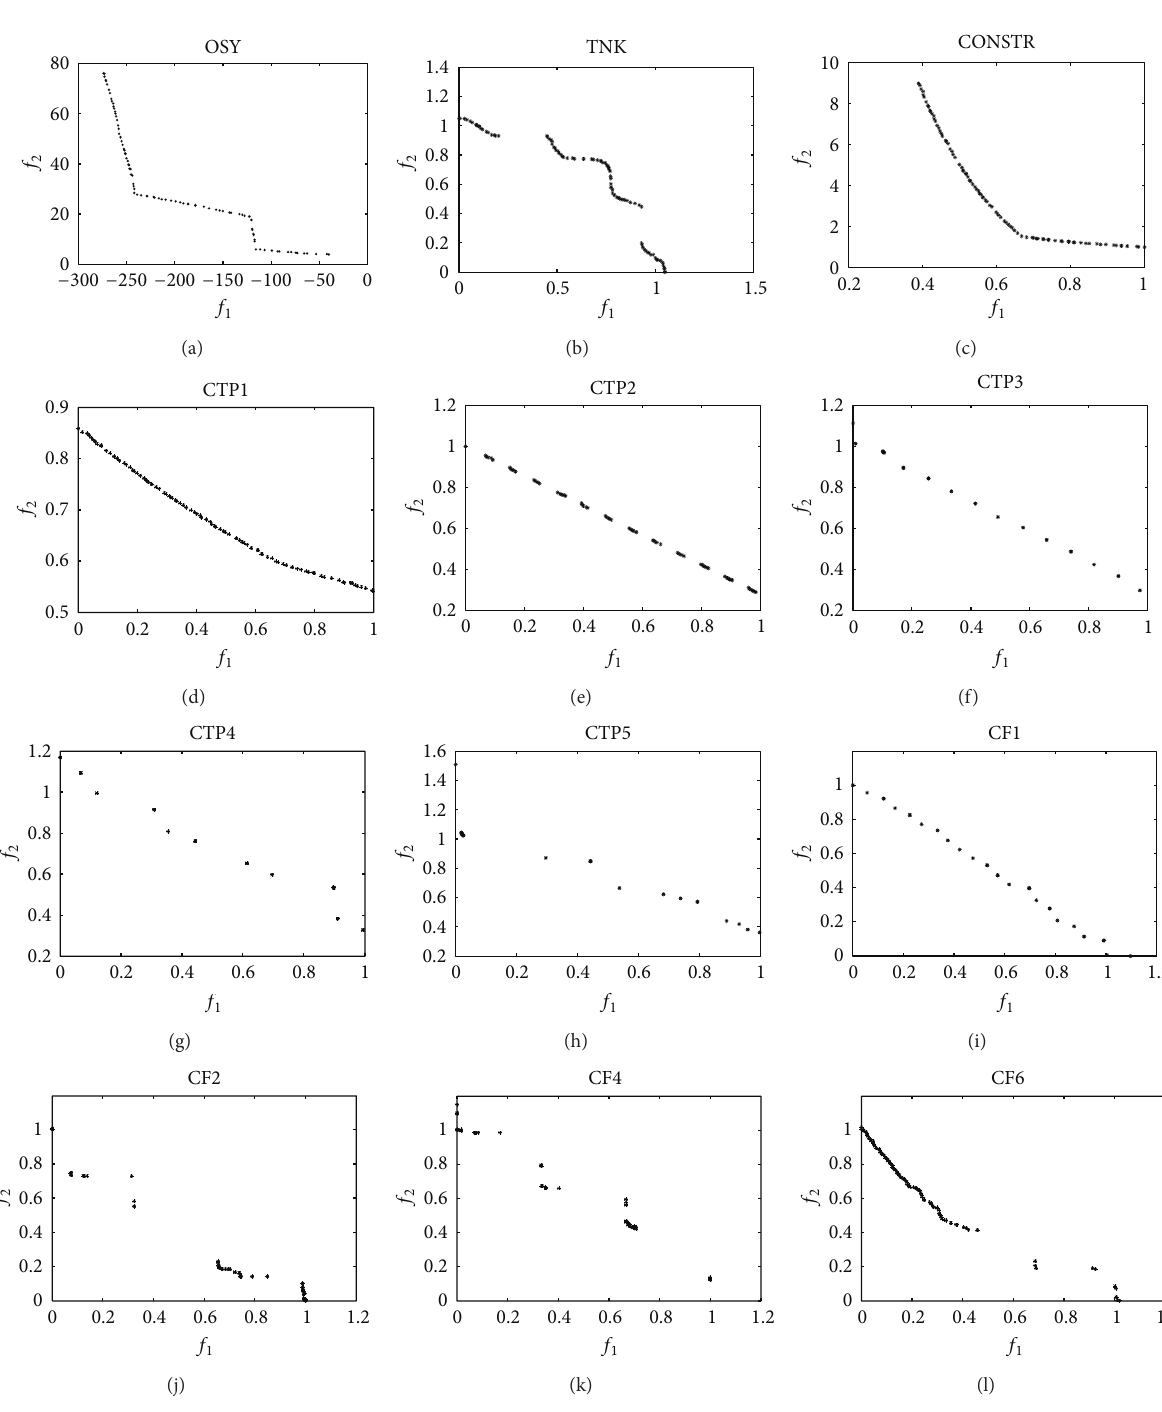
mutation parameter = 20 comparison probability =